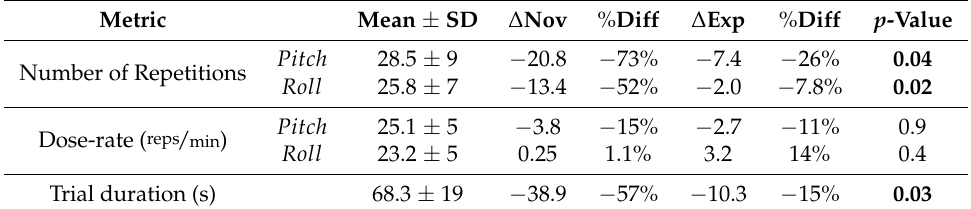
Table 3. Movement quantity performance metrics and learning differences for participants with video-game experience (n = 10). Descriptive statistics (mean ± SD) are presented across participants and trials. Motor learning was compared between the novice ( ∆ Nov, n = 5) and experienced ( ∆ Exp, n = 5) groups by evaluating the change in metric between the first and last trials. The corresponding percent differences (%Diff) are also included. Significant differences ( p <0.05) are indicated with bold font.